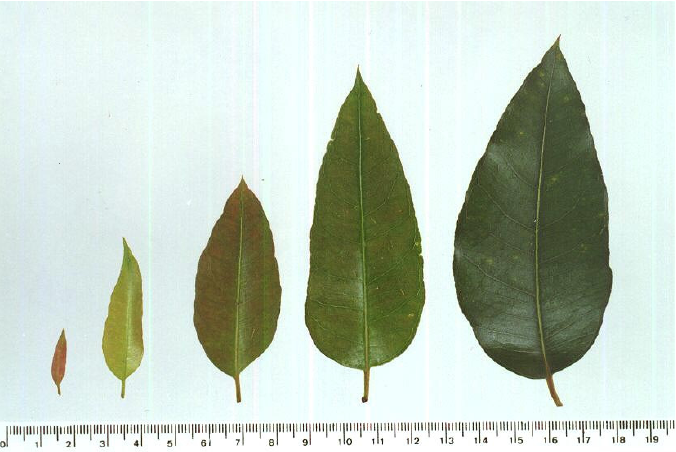
Figure 1. Visual scale of Eucalyptus grandis leaves at the five representative development stages from 6- and 20-month-old plants based on the shape and color of the leaf blade. A scale (cm) is below and the leaves were placed in order according to their position on the